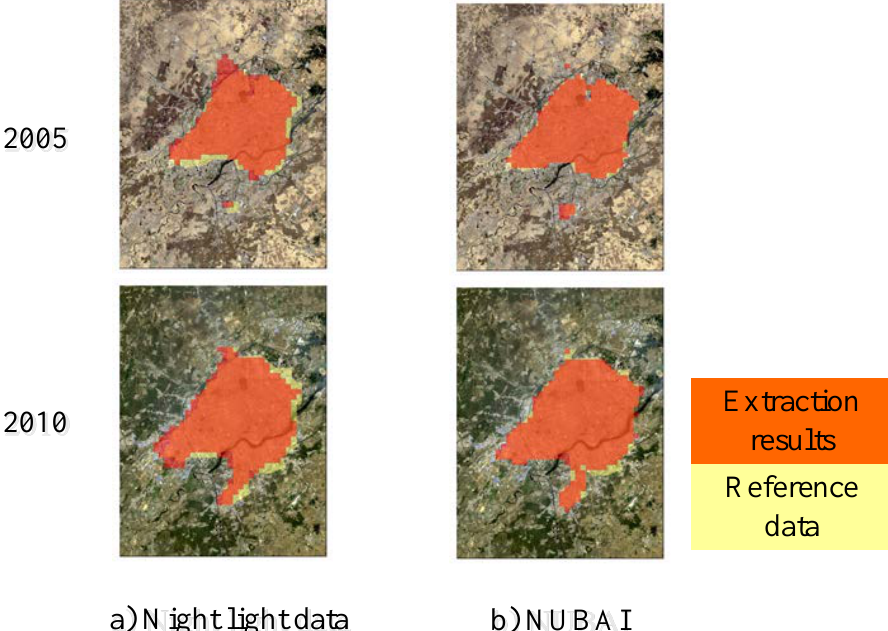
Figure 5. Verification of the spatial locations. ( a ) Night light data and ( b ) NUBAI. Table 2. Statistics of the omitted area sizes and misidentified area sizes.